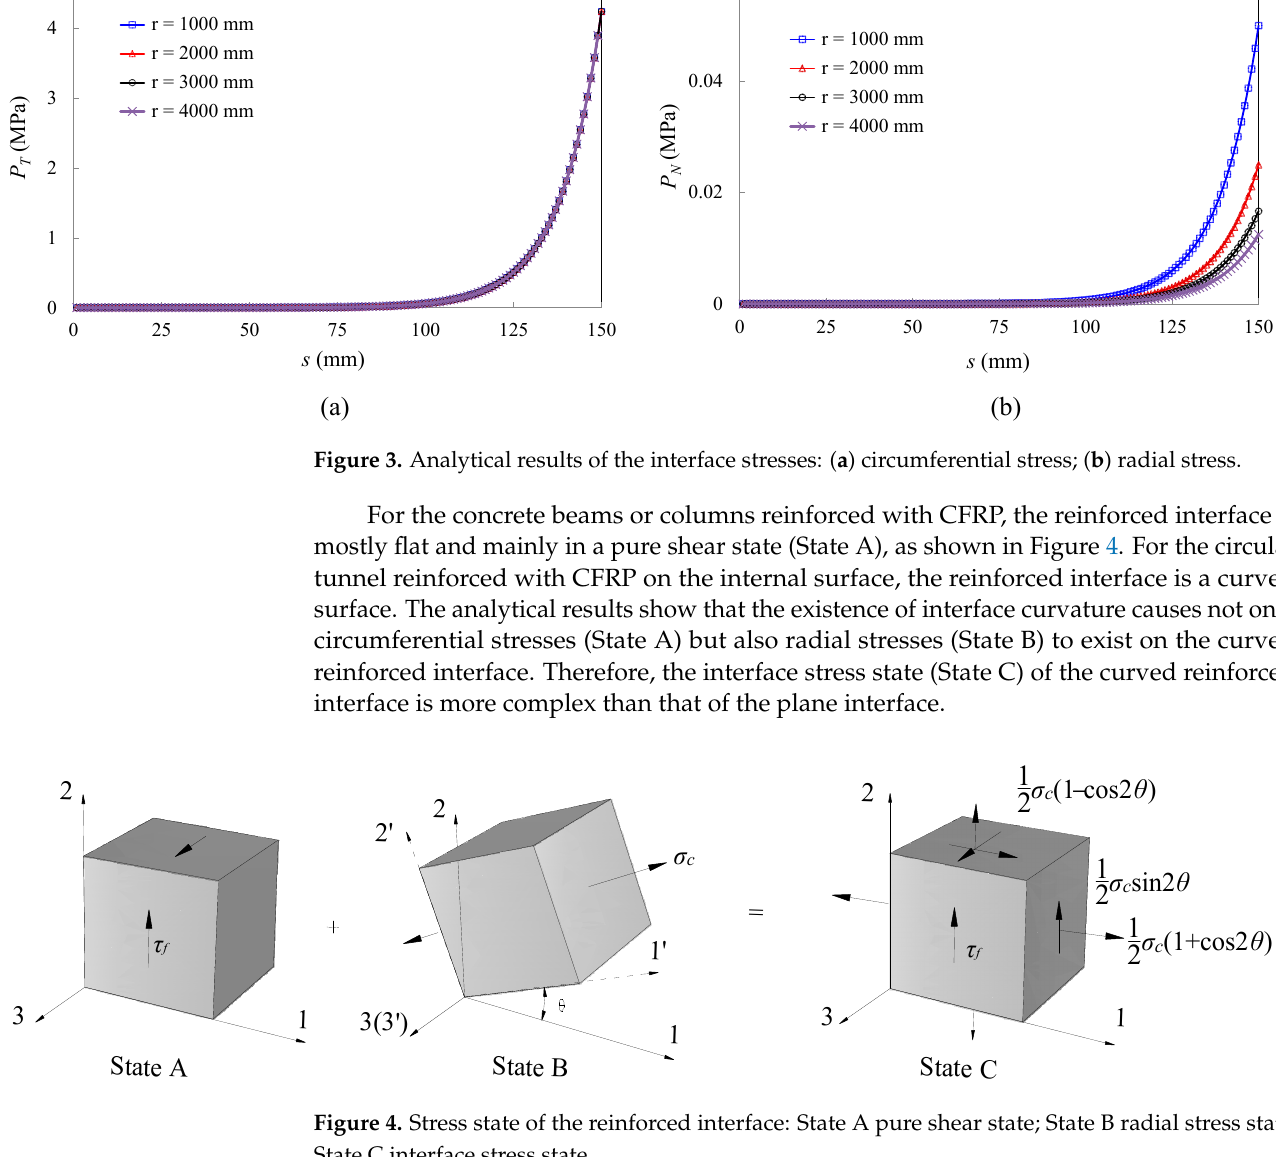
Figure 4. Stress state of the reinforced interface: State A pure shear state; State B radial stress state; State C interface stress state.